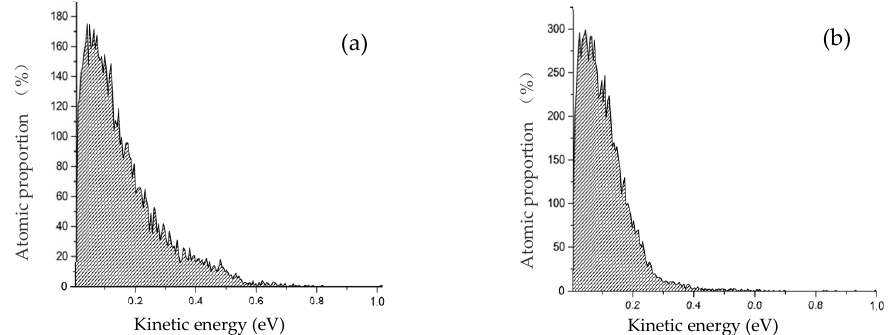
Figure 17. Instantaneous atomic kinetic energy distribution of different chip forms. ( a ) Kinetic energy distribution of spherical chip; and ( b ) kinetic energy distribution of strip chip.